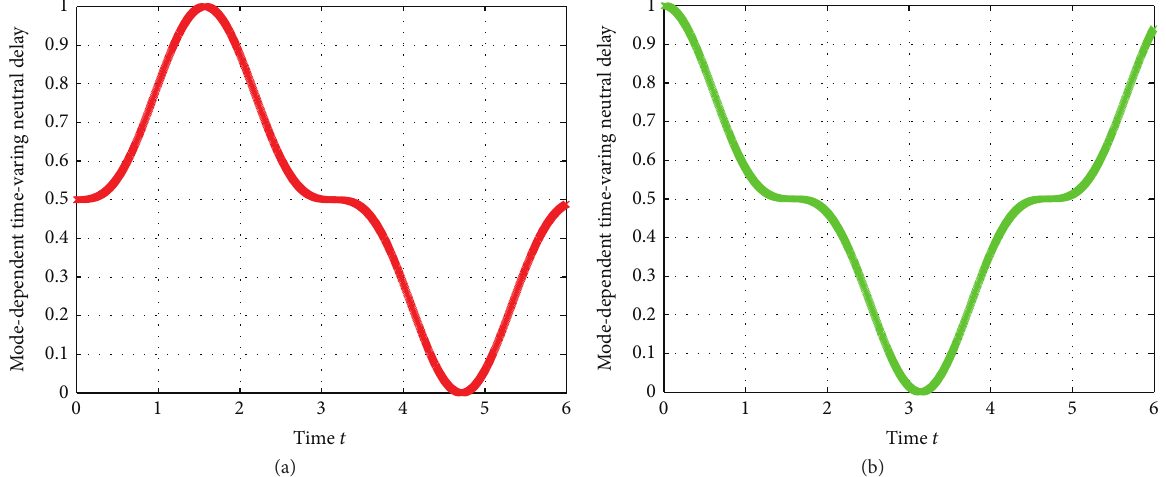
Figure 1: Mode-dependent time-varying neutral delays 𝜏 𝑖 (𝑡) at mode 1 and mode 2.